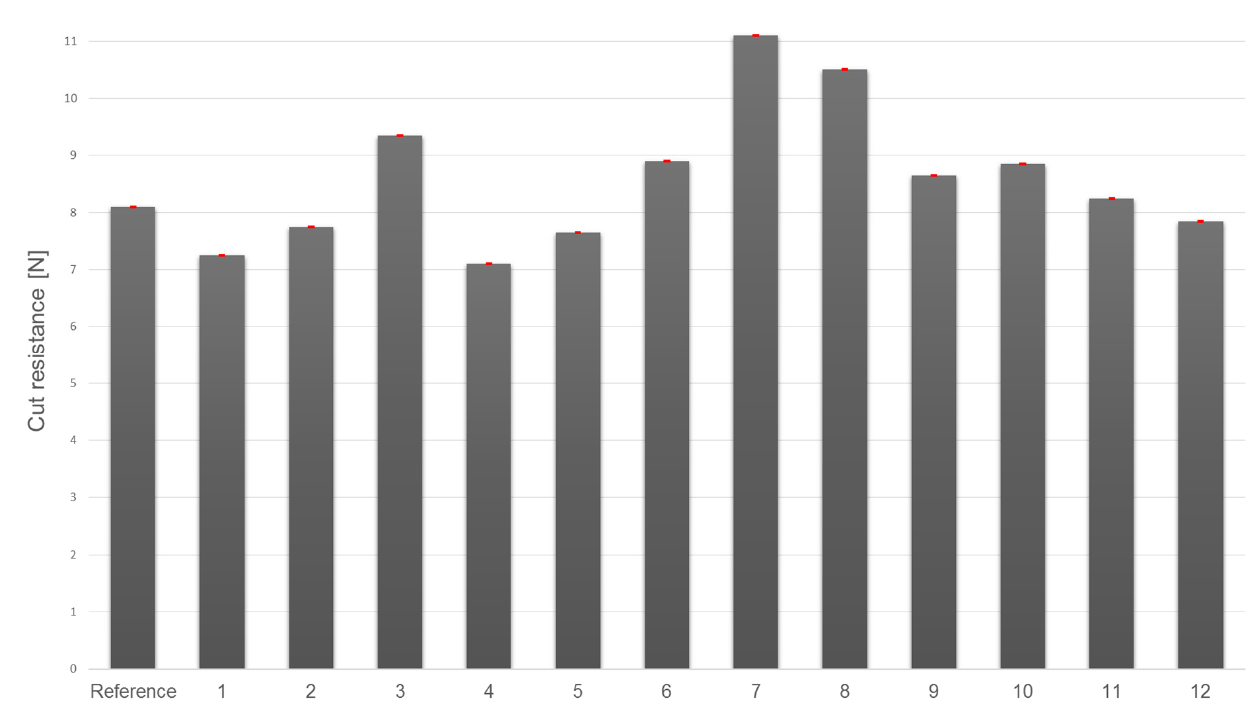
Figure 8. Cut resistance results.